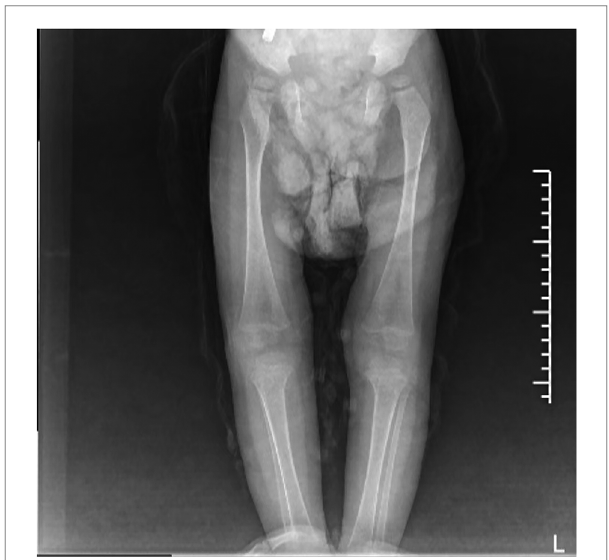
FIGURE 2 Signs of GD on both sides of the femur and tibia on October 21, 2021: enlarged and fl ask-shaped distal femur and proximal tibia on both sides, widened bone marrow cavity, and reduced bone density. No abnormal signs were observed in soft